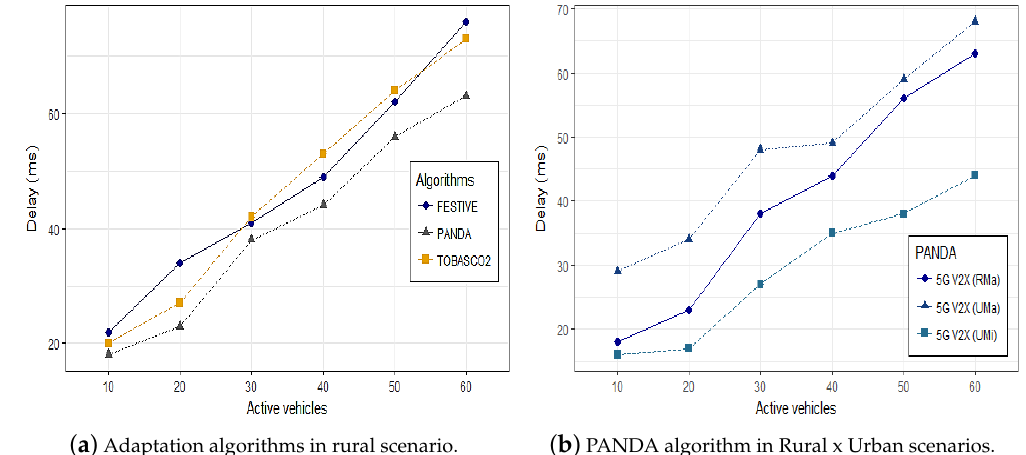
Figure 8. Average delay in a fog cell 5G V2X.